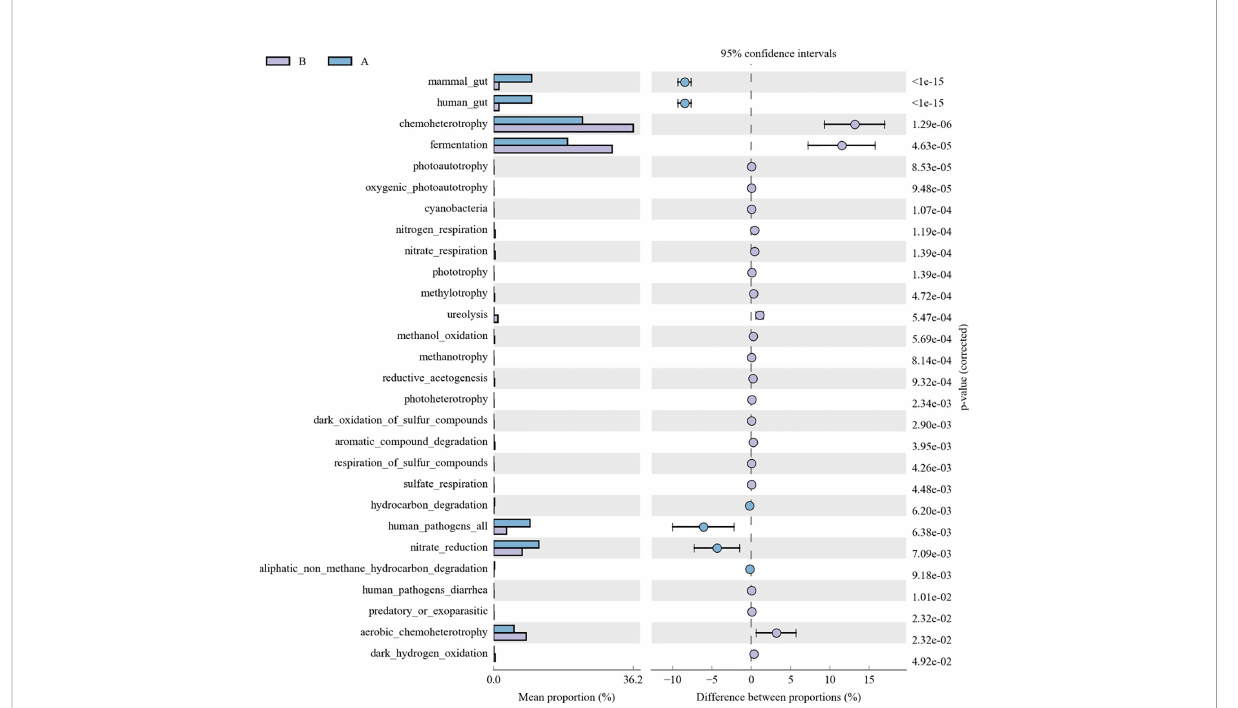
FIGURE 12 FAPROTAX analysis of LRTI children with/without hematological malignancies. A re fl ect BALF samples of LRTI children with hematological malignancies; B re fl ect BALF samples of LRTI children without hematological